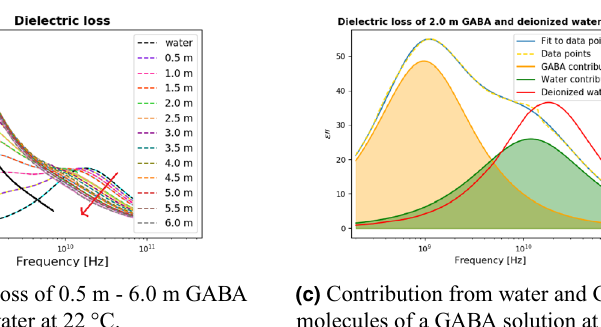
Figure 1. Real ( ǫ ′ ) and imaginary ( ǫ ′′ ) parts of the complex permittivity of GABA solutions and pure deionized water together with the fitted permittivity spectra as a function of frequency, at 22 °C. GABA concentration ranges from 0.5 to 6.0 m with a 0.5 m step length between each of the concentrations. Dashed lines represent the experimental data points and solid lines represent the fit to the relaxation model (1). Figure 1c, the solid blue curve represents a non-linear square fit to the experimental dielectric loss data points, and the dashed yellow curve shows the experimental data points. In addition, the red solid curve represents the dielectric loss spectrum for pure deionized water. Dielectric measurements were performed in a frequency range 200 MHz–67